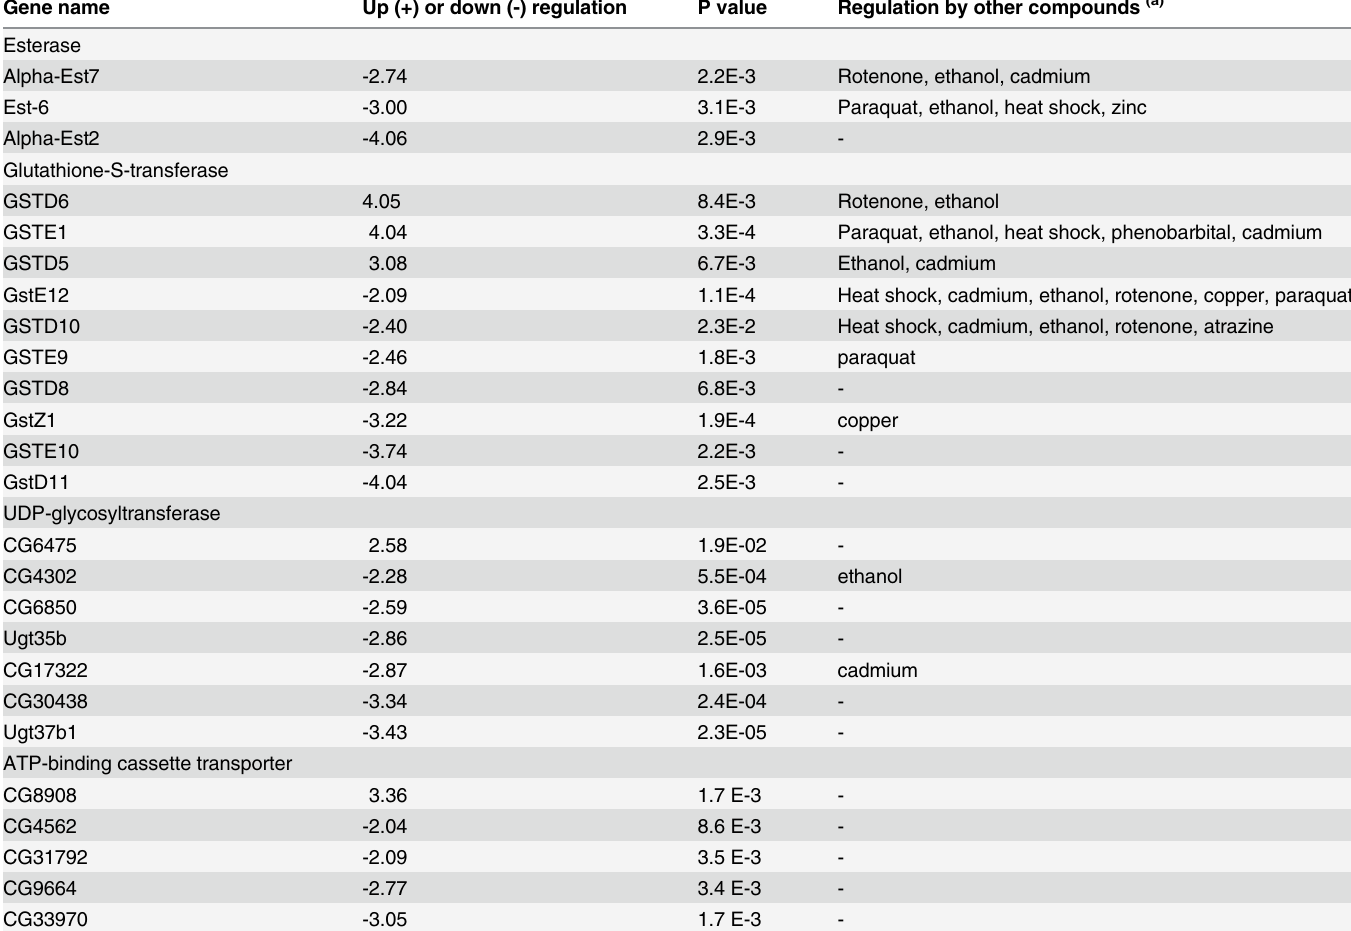
Table 2. Expression of major detoxi fi cation genes in Drosophila melanogaster after caffeine exposure. Gene